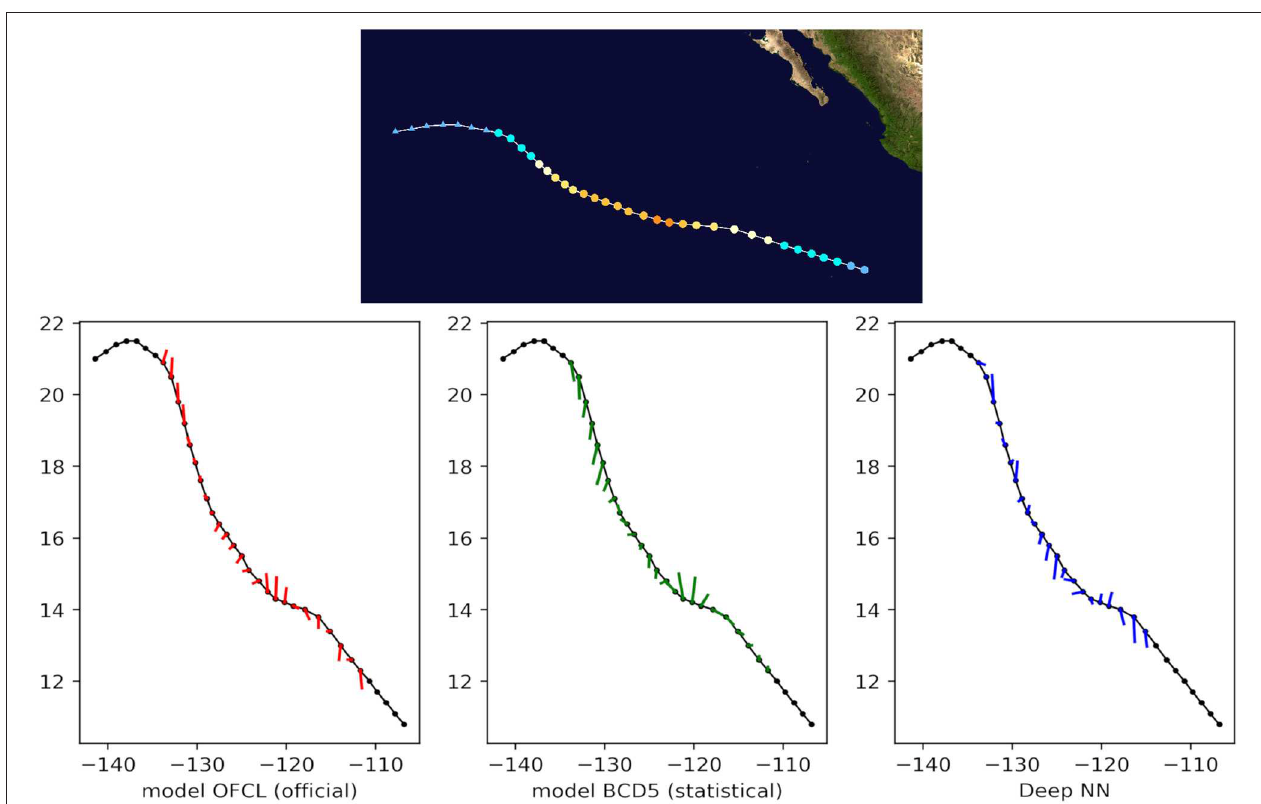
FIGURE 9 | 24-h forecast errors (4 time steps ahead) on Tropical Cyclone Blas in 2016. The bars connect each pair of predicted and ground truth location. The longer the length, the larger the error. At the beginning and at the end of the track, the forecasts were not always available (a complete absence of an error bar should be interpreted as no forecast